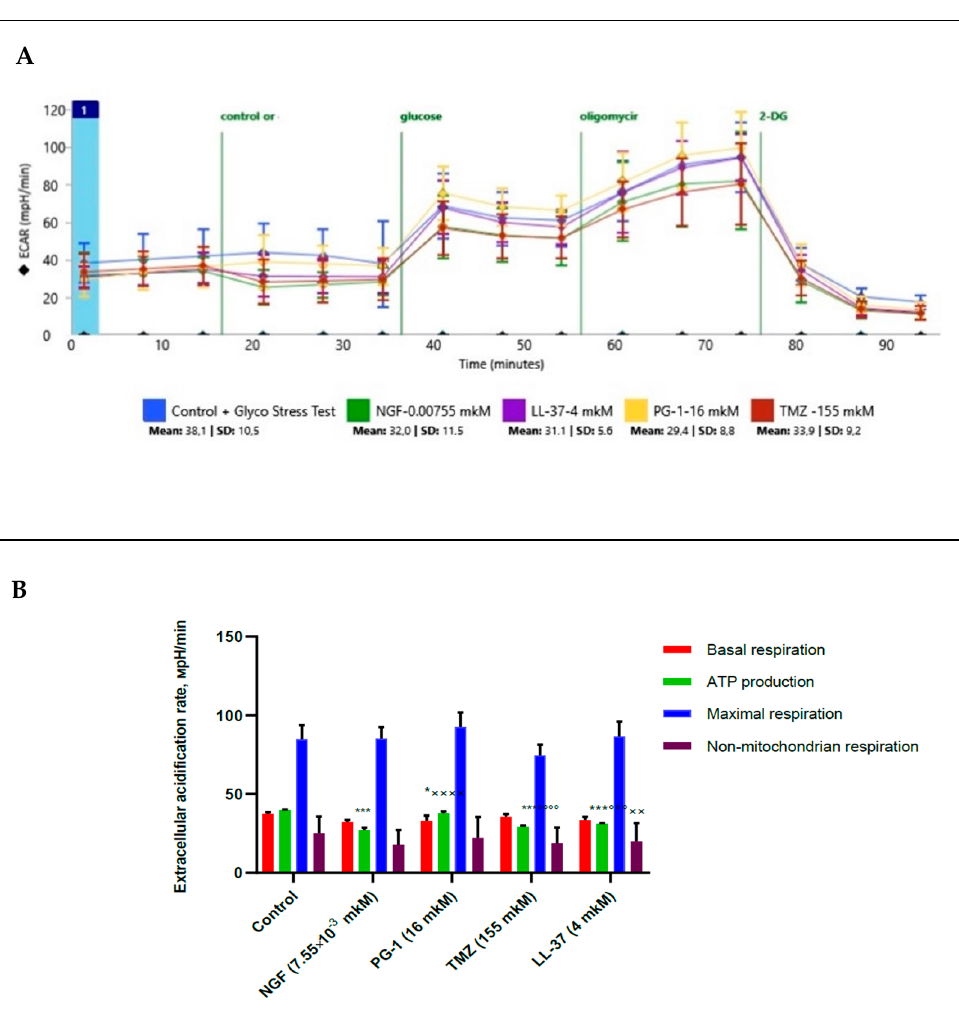
Figure 4. Extracellular acidification rate (ECAR) in human U251 glioma cells under the effect NGF.(7.55 × 10 − 3 μ M), LL-37 (4 μМ ), PG-1 (16 μМ ) and TMZ (155 μМ ) over time ( A ); in comparison